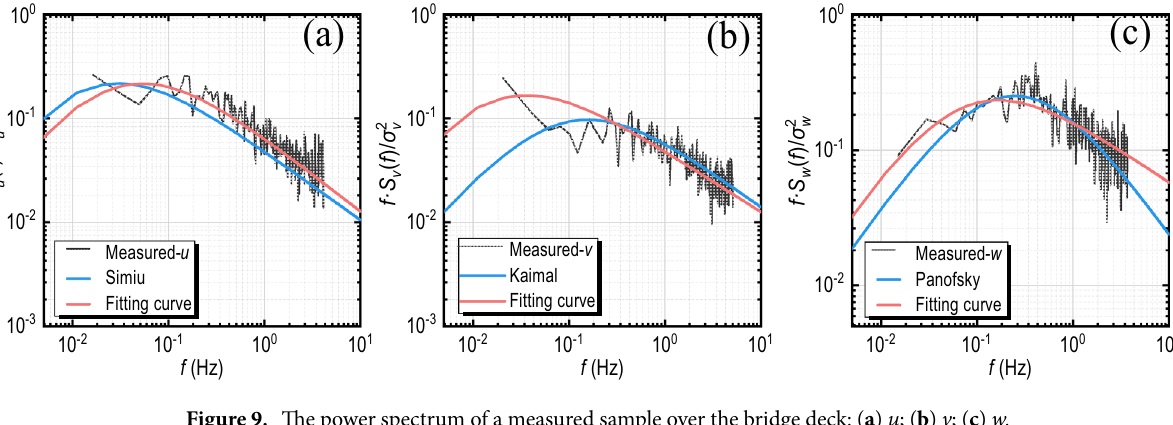
Figure 9. The power spectrum of a measured sample over the bridge deck: ( a ) u ; ( b ) v ; ( c )